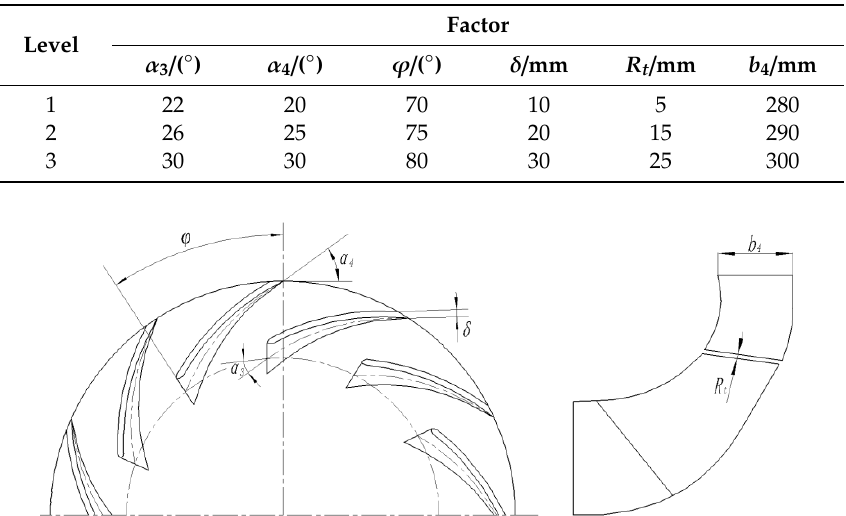
Table 1. Level of di ff erent factors.